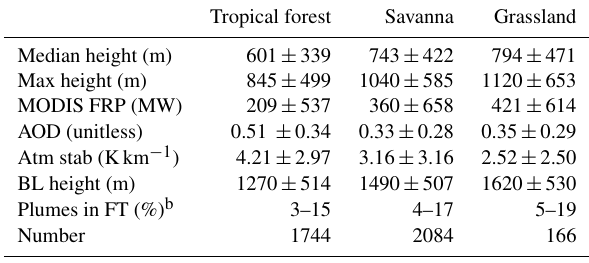
Table 2. Statistical summary for main smoke plume parameters and atmospheric conditions a . Atm stab is atmospheric